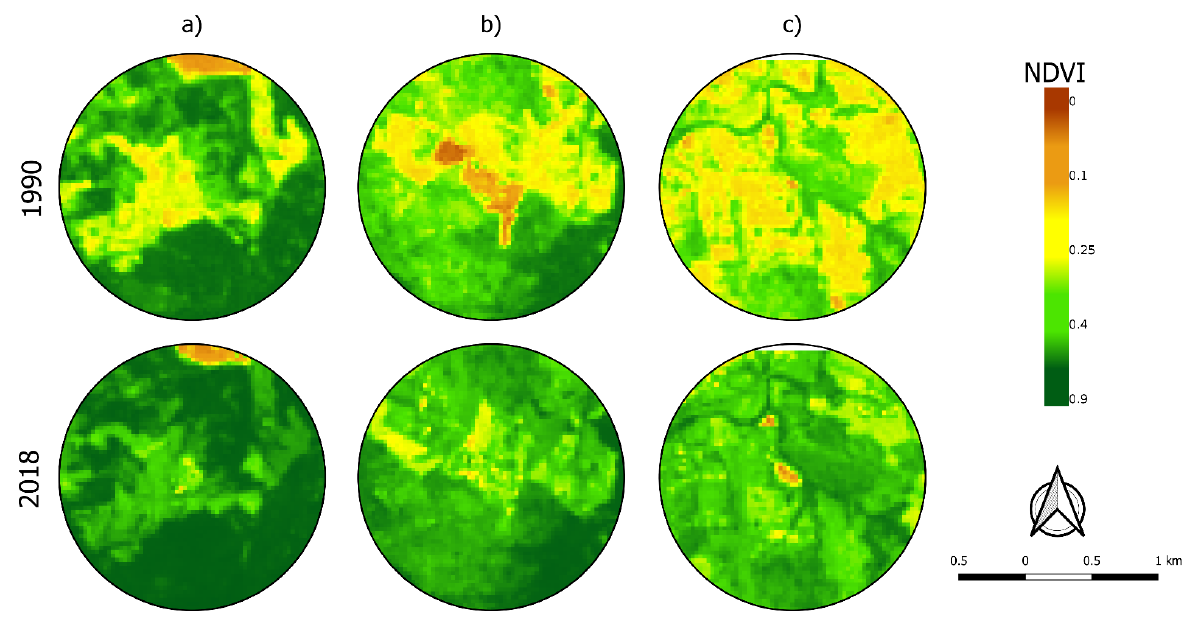
Figure 3. Initial and final NDVI maps of the three study areas: ( a ) Aia dei Monaci, ( b ) Montegrosso-Pallareta, ( c ) Vallone Calabrese.